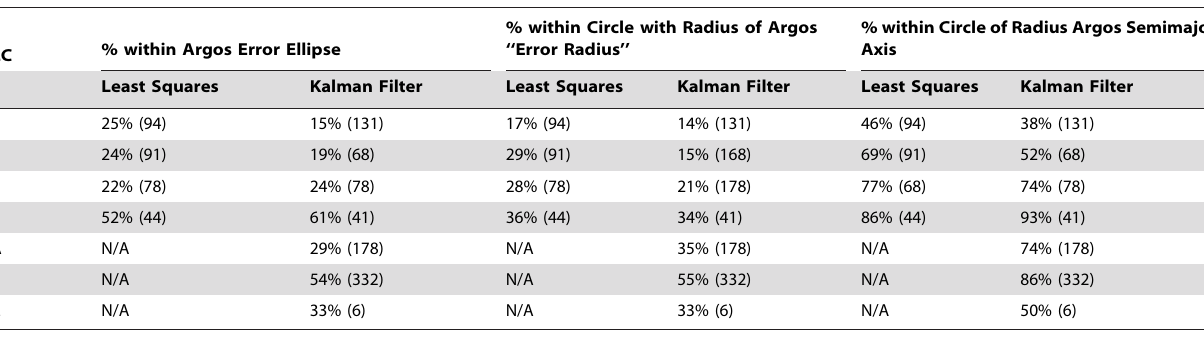
Table 7. Percentage of true locations captured within error ellipse or circle.